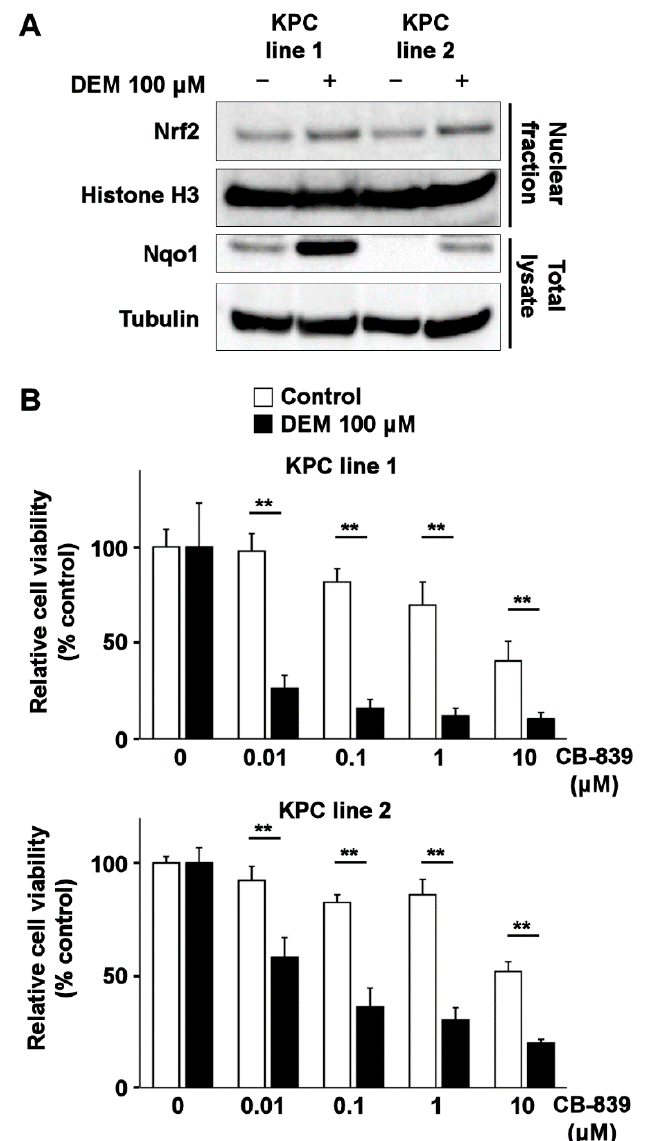
Figure 4. Induction of Nrf2 and sensitization to CB-839 by DEM treatment in KPC lines. ( A ) Nuclear accumulation of Nrf2 and induction of Nqo1 expression in KPC cell lines after DEM treatment. Histone H3 and tubulin are displayed as loading controls for proteins present in the nuclear and cytosolic fractions, respectively. ( B ) MTT assay for analyzing the viability of KPC cell lines after CB-839 treatment ( N = 6, 5000 cells/well, 48 h; with or without DEM pretreatment (100 μ M, 24 h)). ** indicates p < 0.01 by the Tukey − Kramer method. The error bars show standard deviations.